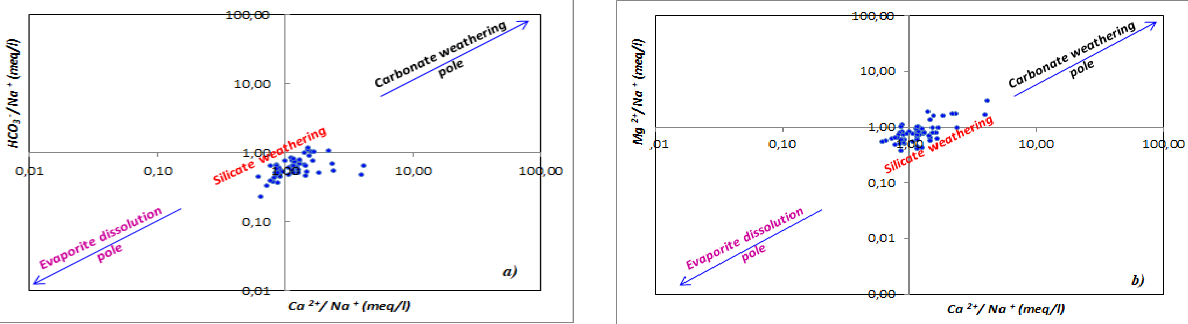
Fig. 8. Plot of (a) HCO 3- /Na + versus Ca 2+ /Na + and (b) Mg 2+ /Na + versus Ca 2+ /Na + relating to silicate and carbonate